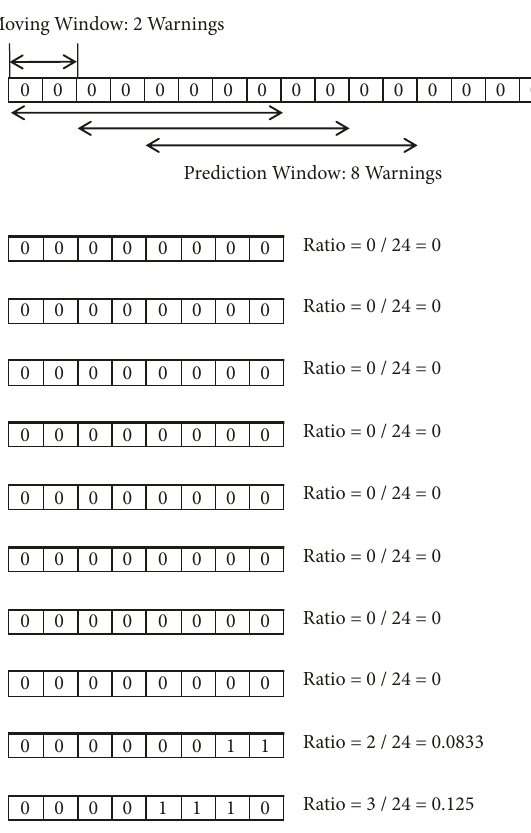
Figure 17: Prediction algorithm results for test subject 1 while